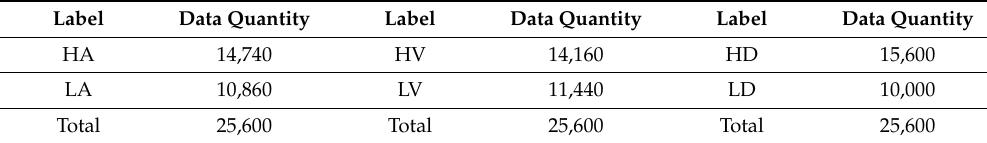
Table 1. Distribution of samples. HA: high arousal; HD: high dominance; HV: high valence; LA: low arousal; LD: low dominance; LV: low valence.